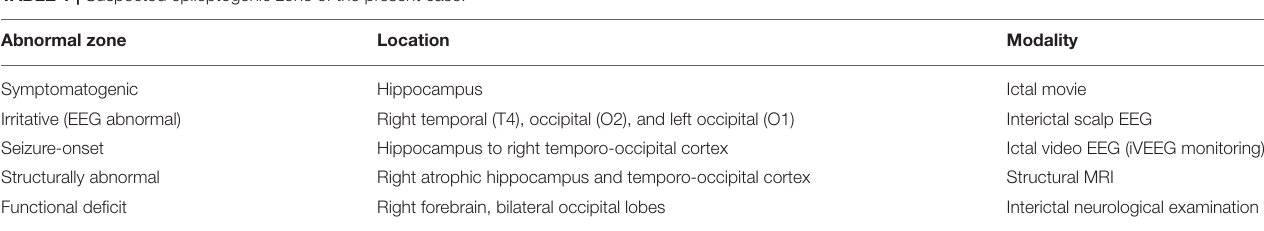
TABLE 1 | Suspected epileptogenic zone of the present